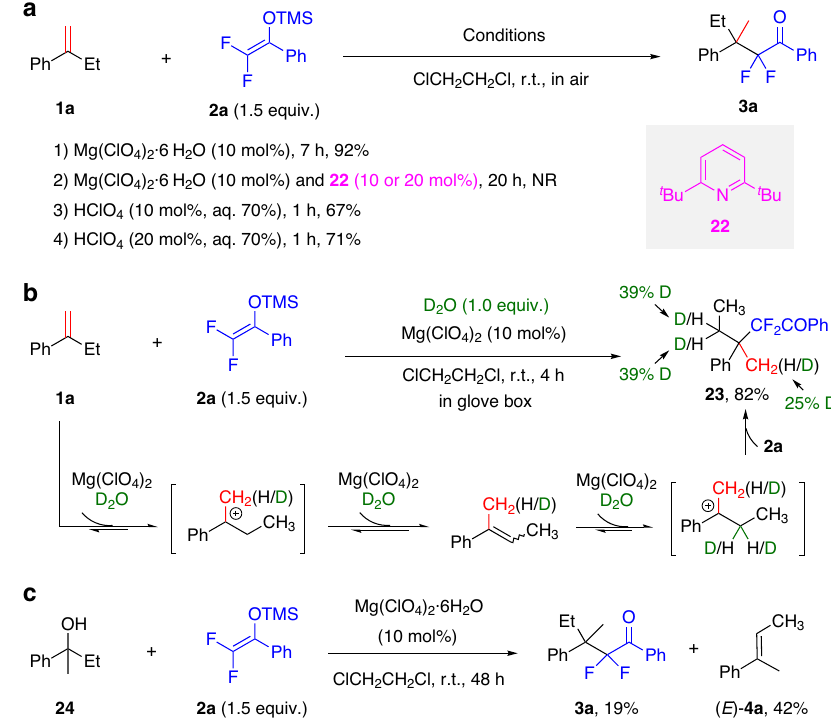
Fig. 7 Mechanistic study. a Control experiments. b Experiments with D 2 O. c Experiments with tertiary alcohol 24